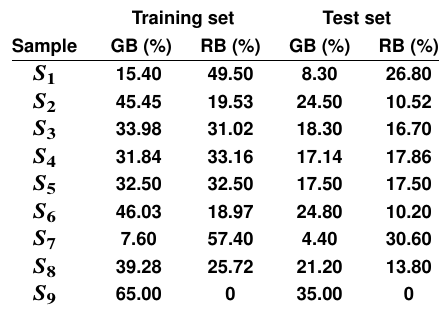
Table 4. Proportions of green/red behavior (GB/RB) in the training and test sets